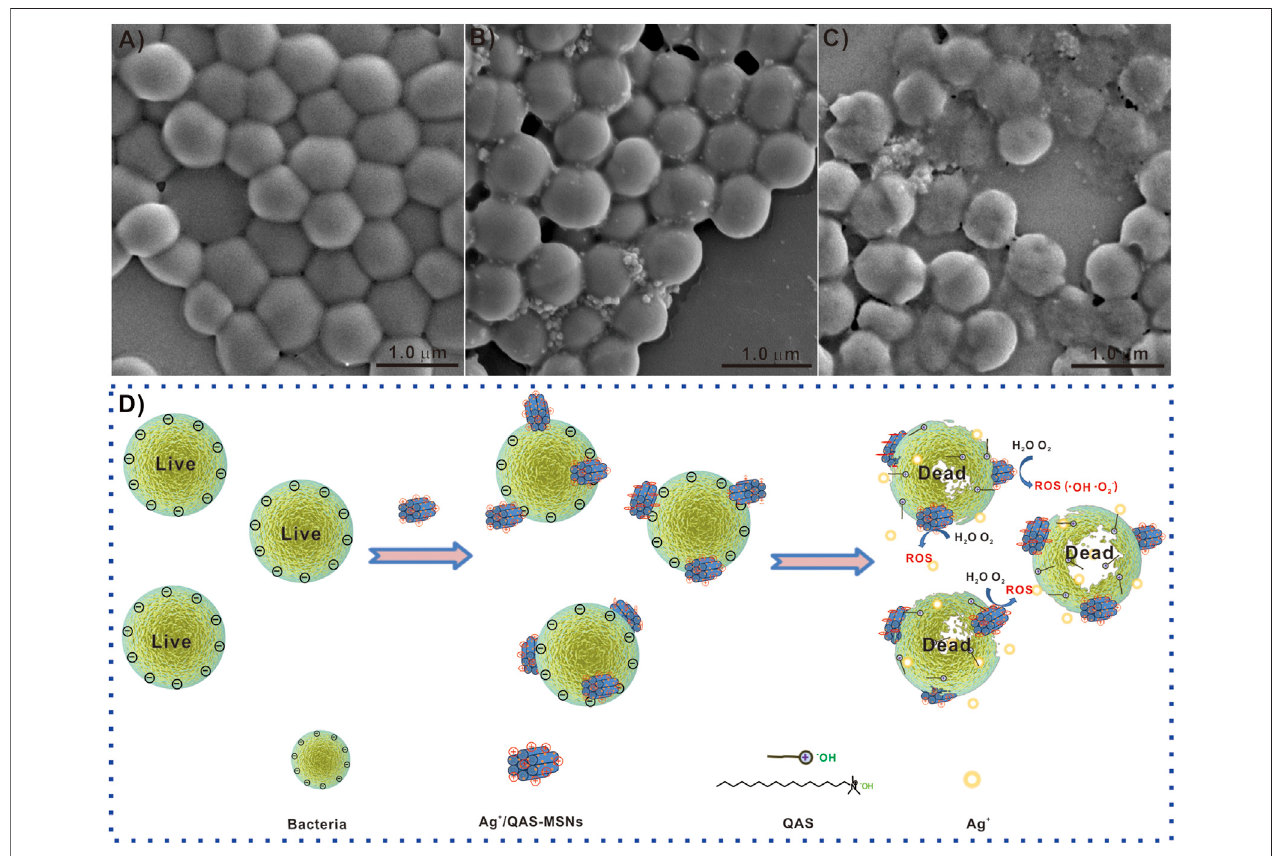
FIGURE 7 | SEM images of S. aureus treated with Ag/QAS-MSNs: (A) 0 ppm (control), (B) 40 ppm for 30 min, and (C) 40 ppm for 8 h. (D) The possible antibacterial mechanism of Ag/QAs-MSNs.